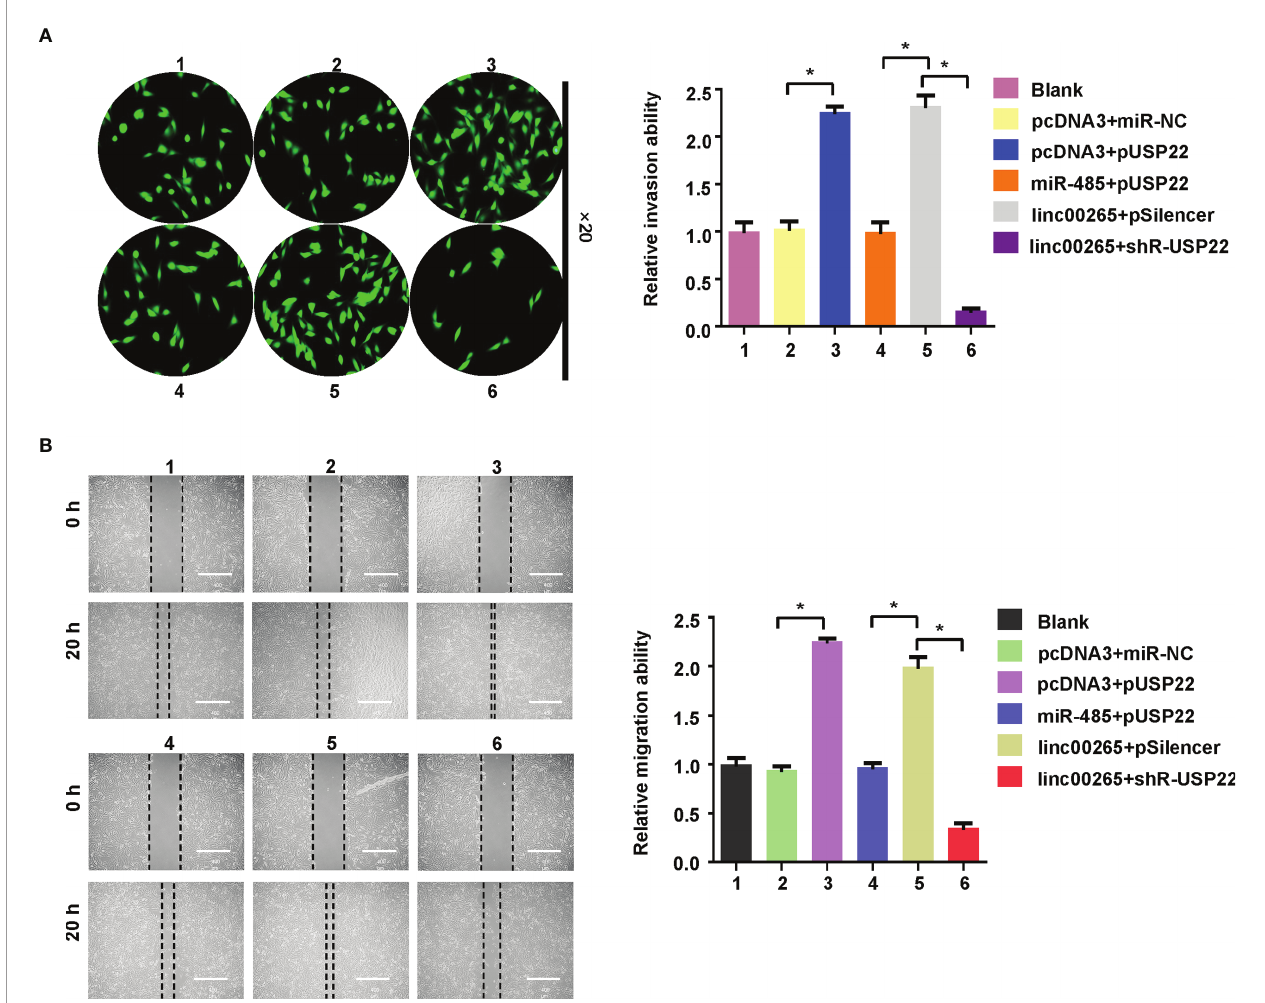
FIGURE 7 | Linc00265 enhanced migration and invasion via miR-485-5p/USP22 axis. (A) Cell invasion was examined by Transwell invasion assay in osteosarcoma cells after linc00265 modi fi cation, miR-485-5p changes, or USP22 modi fi cation or combination. (B) Cell migration was measured by wound healing assay in osteosarcoma cells after linc00265 modi fi cation, miR-485-5p changes, or USP22 modi fi cation or combination (Left panel). The quantitative data were demonstrated for wound healing assay (Right panel). 1: Blank. 2: pcDNA3 + miR-NC. 3: pcDNA3 + pUSP22. 4: miR-485 + pUSP22. 5. Linc00265 + pSilencer. 6. Linc00265 + shR-USP22. * P < 0.05 vs.